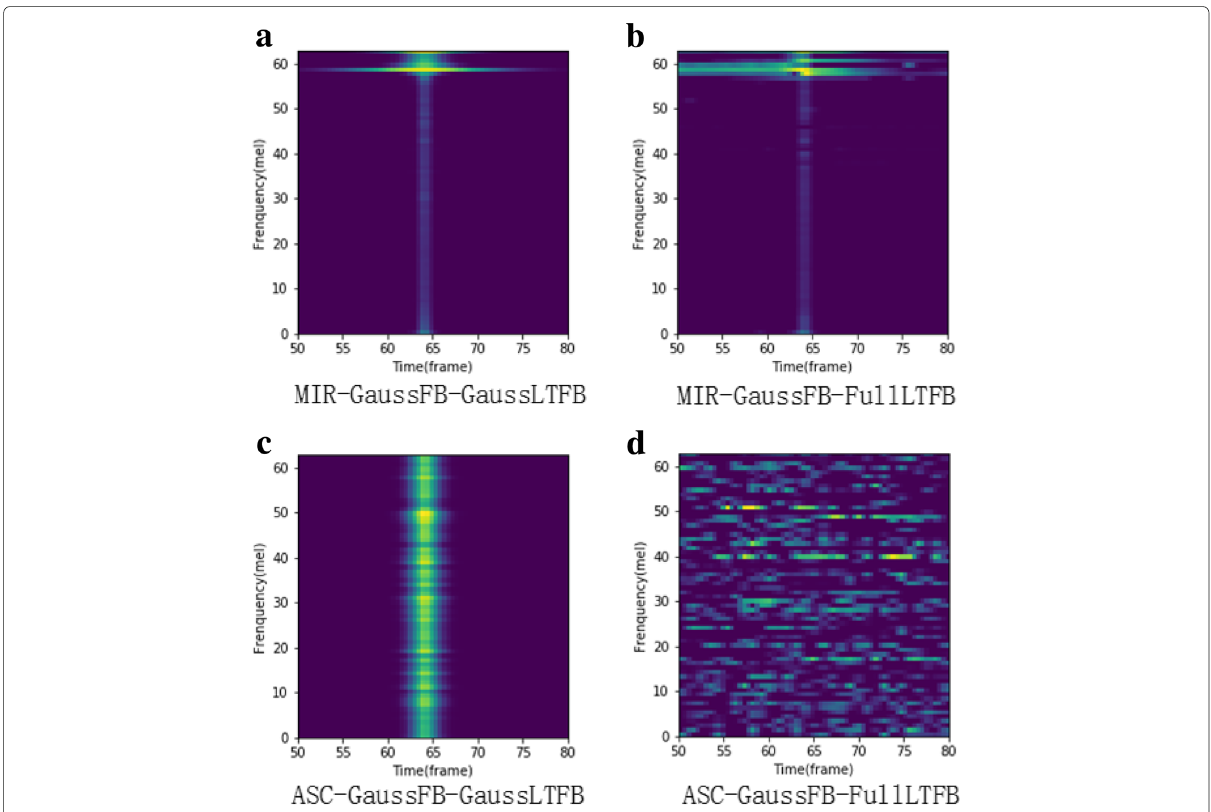
Fig. 8 Time durations of long-term filter banks in different tasks. a , b The long-term filters learned on MIR-1K dataset. c , d The long-term filters learned on DCASE2016